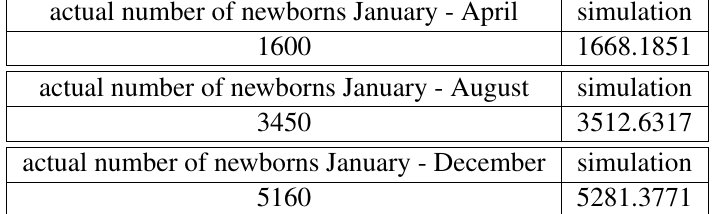
Table 2 Comparison between the actual and the simulated number of newborns